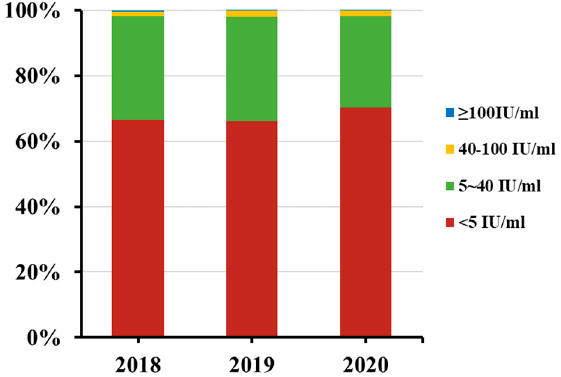
Figure 2. Distribution of serum anti-PT IgG antibody concentrations in adults aged 20~39, Beijing, China, 2018–2020. The numbers of serum specimens with anti-PT IgG antibody concentrations ≥ 100 IU/mL, 40~100 IU/mL, 5~40 IU/mL, and <5 IU/mL in each group were calculated, and the data are shown as percentages. No statistical difference was observed among these three years.